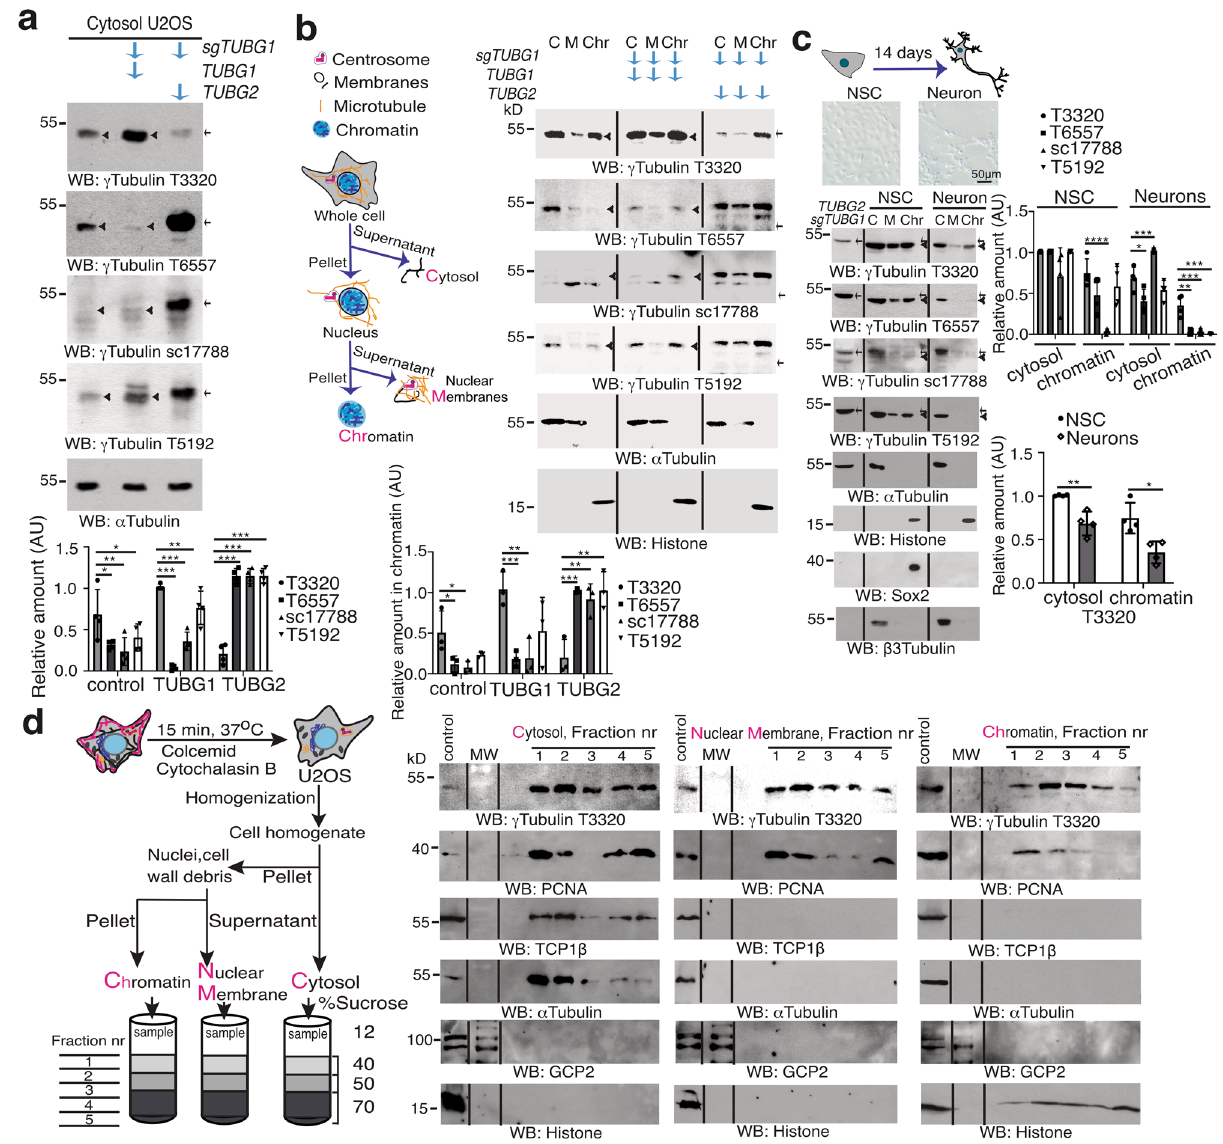
Fig. 1 Despite 97.55% homology between γ -tubulin 1 and γ -tubulin 2, the proteins exhibit different conformations. a – c The cytosolic fraction ( a ; N = 4) of U2OS cells or such cells stably expressing TUBG1 single guide (sg) RNA (sg TUBG1 , knocks out TUBG1 gene) and co-expressing either a sg-resistant TUBG1 or a sg-resistant TUBG2 ( a , b ) was analyzed by western blotting (blots designated WB). b , c U2OS cells ( N = 3), human H9 neural stem cells (NSCs), and H9 cells differentiated for 14 days into neurons (1.0 × 10 6 ) were lysed, and proteins were biochemically divided into cytosolic (C), nuclear membrane (M), and chromatin fractions (Chr) and then analyzed by WB. c U2OS cells stably expressing TUBG1 sgRNA and co-expressing a sg-resistant TUBG2 ( TUBG2 sg TUBG1 ) were used as control ( N = 4). a – c The expression of endogenous and recombinant γ -tubulin was analyzed using the following mouse (m) or rabbit (r) antibodies: T3320 (r) and sc17788 (m) raised against the C terminus of γ -tubulin; and T6557 (m) and T5192 (r) raised against the N terminus of γ -tubulin. Anti-Sox2 (NSC marker) and anti- β 3-tubulin (neuronal marker) antibodies were used as markers of neuronal differentiation and anti- α -tubulin and anti-histone as loading controls. Black arrowheads and arrows indicate γ -tubulin 1 and γ -tubulin 2, respectively. c Microscopic images showing the cell morphology of whole NSCs and neurons, as indicated. The graphs in a – c illustrate densitometric analysis of the γ -tubulin content in the presented WB. To adjust for differences in protein loading, the concentration of a protein was determined as its ratio with α -tubulin ( a – c ) or histone ( b , c ). d In the absence of detergent, U2OS cells (20 × 10 6 ) were biochemically divided into cytosolic, nuclear membrane, and chromatin fractions and then layered onto a sucrose gradient. The resulting fractions were analyzed by WB with the indicated antibodies. Total lysate from U2OS cells was run as control ( N = 5). Molecular weight (MW) was loaded between samples and control. b – d Flow scheme of the biochemical fractionations performed ( b , d ) or of the morphological changes occurring in NSCs during differentiation ( c ). b , d The acronyms of the analyzed fractions are labeled in magenta. a – d Source data are provided in Supplementary Data